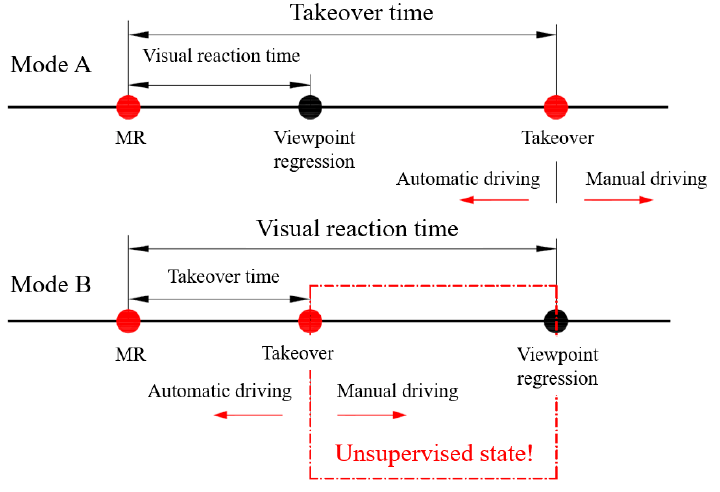
Figure 12. Two modes of takeover. Table 7. Number of people with different takeover modes in six scenarios.